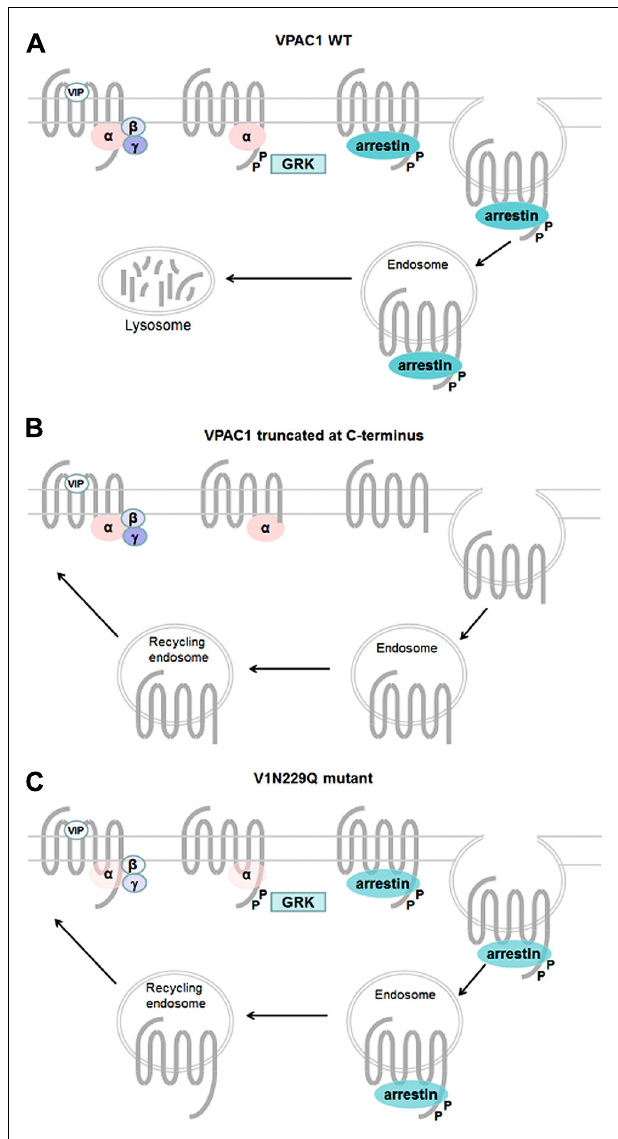
FIGURE 4 | Mechanisms involved in regulation ofVPAC 1 activity. UponVIP binding wtVPAC 1 (A) is rapidly phosphorylated through a GRK-dependent mechanism and desensitized, phosphorylation promotes high affinity binding of β -arrestin toVPAC 1 and internalization into endosome through an arrestin- and dynamin-dependent mechanism. After internalizationVPAC 1 is not re-expressed at the cell surface. In some truncatedVPAC 1 receptors (B) ,VIP fails to induce GRK-mediated receptor phosphorylation but the receptor is still able to internalize through an arrestin-independent mechanism and is re-expressed at the cell surface. SomeVPAC 1 receptor mutants (C) , with decrease in potency and efficacy ofVIP-stimulated adenylate cyclase activity, preserved receptor recognition of agonists and antagonist and a preserved sensitivity to GTP, are still phosphorylated and internalized and recycle back to cell